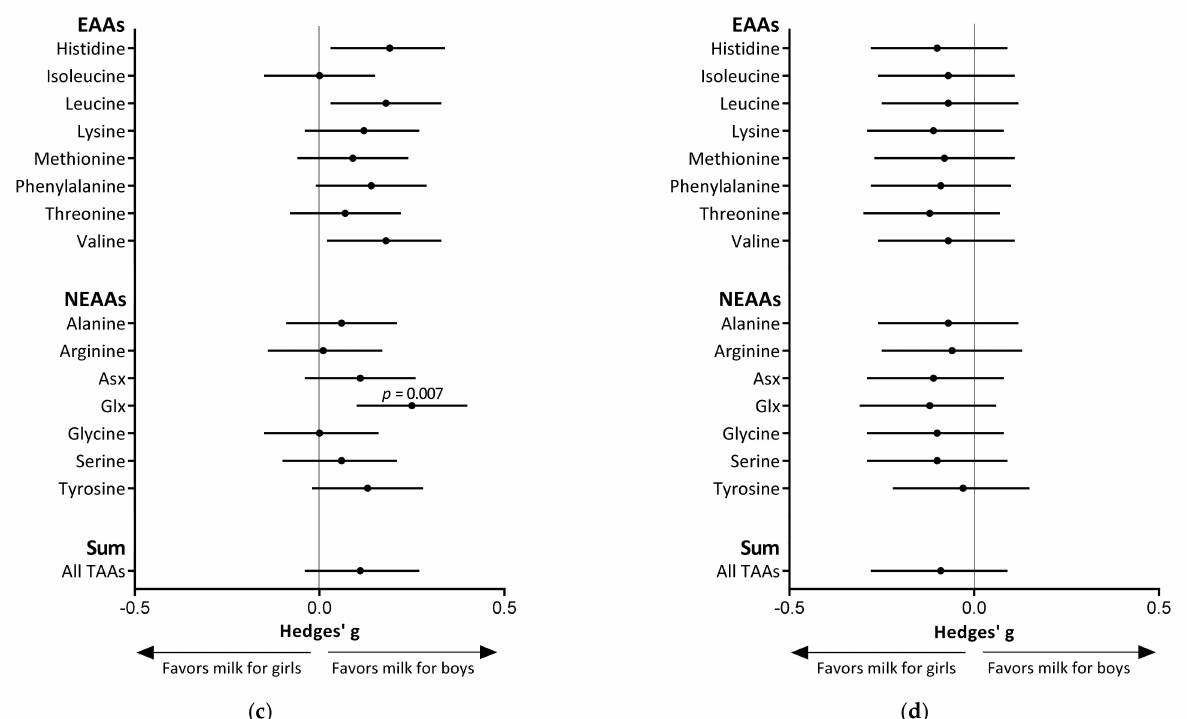
Figure 2. Forest plots indicating the effect sizes (Hedges’ g and 95% CI) of infant sex on free amino acid (FAA) levels in 6-week human milk (HM) ( n = 354 for boys, n = 317 for girls) ( a ) and 6-month HM ( n = 232 for boys, n = 209 for girls) ( b ), and on total amino acid (TAA) levels in 6-week HM ( c ) and 6-month HM ( d ). Sex differences in amino acid levels in HM were assessed by unpaired t -tests. The Bonferroni-adjusted level of statistical significance is α = 0.05/22 = 0.002 for FAA data and α = 0.05/16 = 0.003 for TAA data. AA: amino acid; EAA: essential amino acid; NEAA: non-essential amino acid; Asx: asparagine + aspartate; Glx: glutamate +